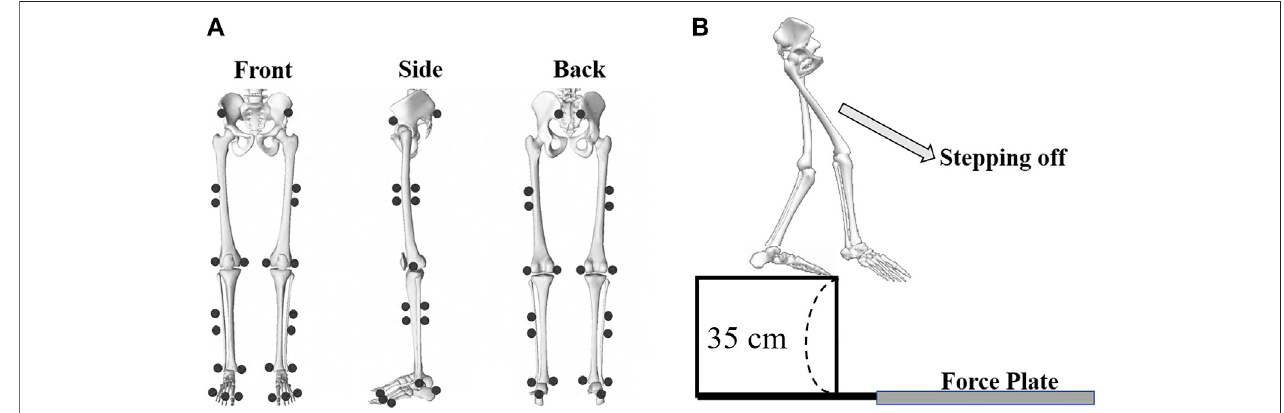
FIGURE 2 | (A) : The re fl ective markers placement (front view, side view, and back view) following bony anatomical landmarks; (B) : The process of subjects conducting single-leg drop landing maneuvers by stepping off a 35 cm platform and landing with the dominant leg onto the center of the force